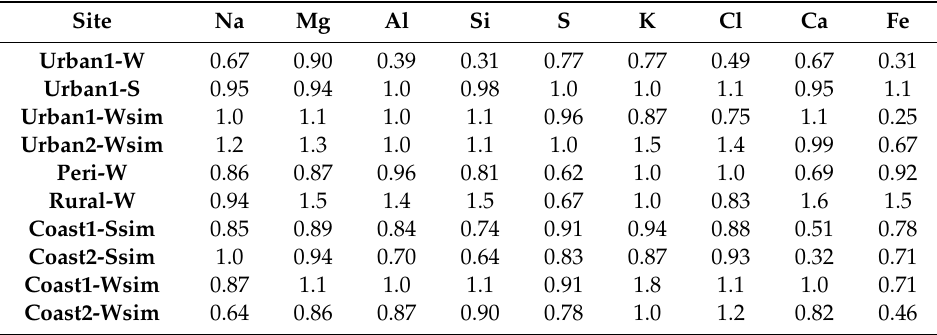
Table 8. Average indoor-to-outdoor concentration ratios calculated for macro-elements.